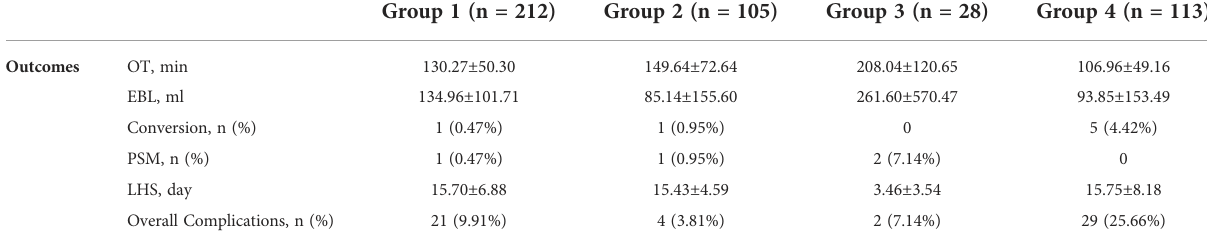
TABLE 4 Surgical